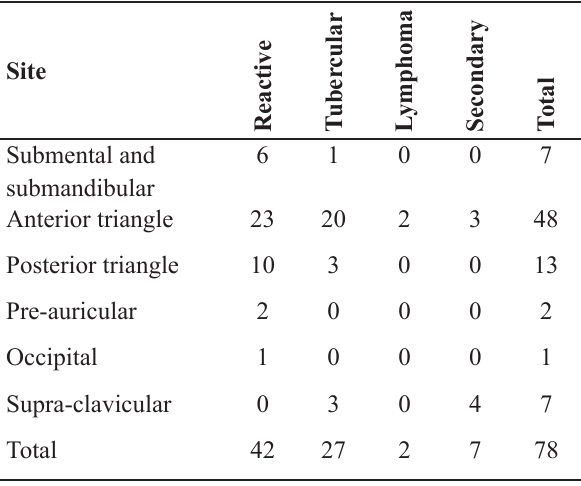
Table 2: Site distribution of cervical lymphadenopathy according to pathology